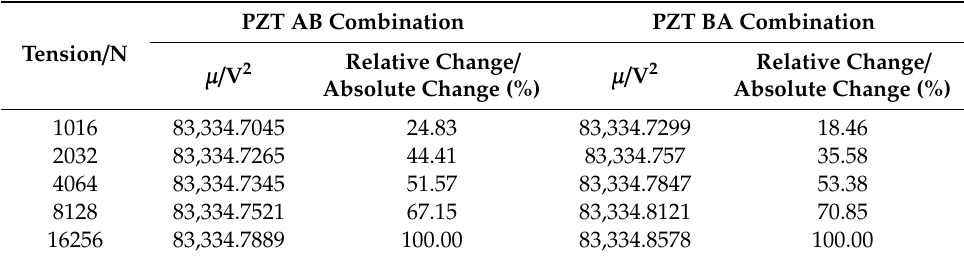
Table 2. Tests results of PZT AB